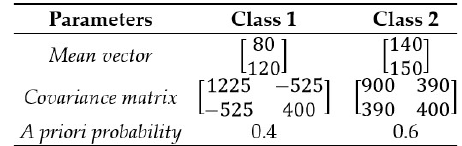
Table 2. Parameters of the bivariate Gaussian distribution.